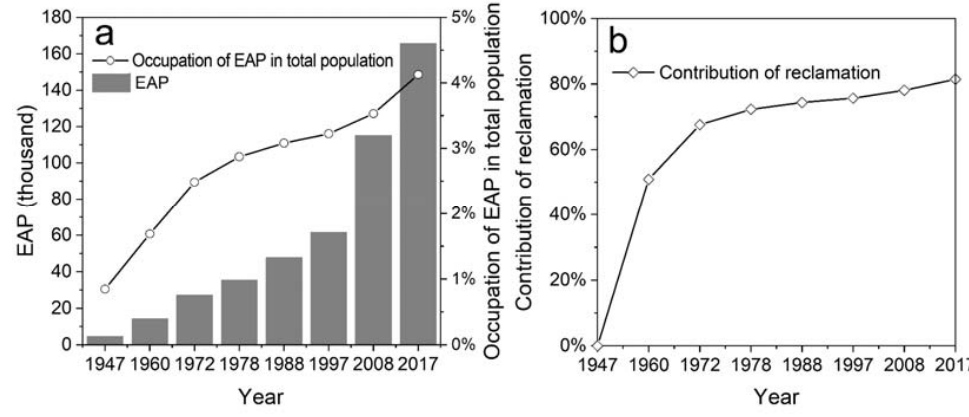
Figure 8. ( a ) Expected annual population (EPA) exposed to coastal flooding, and ( b ) the contribution of land reclamation, from 1947 to 2017 .